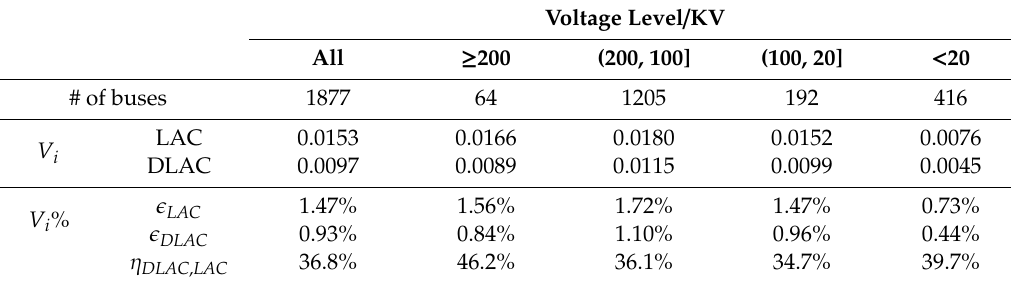
Table 12. Results of Voltage with DLAC and LAC for Hour 2